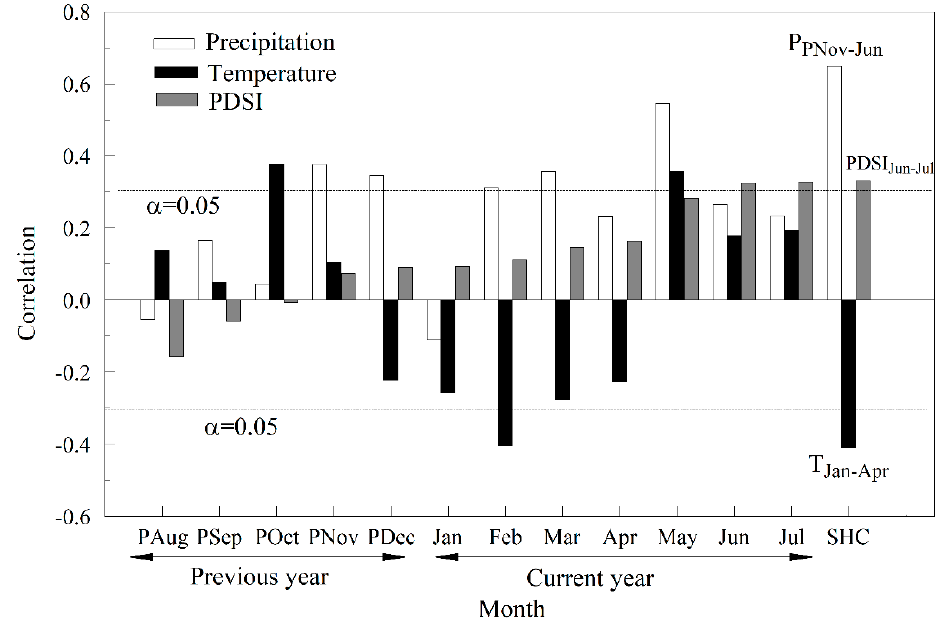
Figure 5. Correlation between the CNDVI JJ and several climatic parameters. Correlation between the CNDVI JJ of the CW–DHM and precipitation, temperature (both from CRU TS4.01, 47.5° N– 49.5° N, 119.0° E–120.5° E, 1982–2013 CE), and PDSI [23] (47.5° N–49.5° N, 119.0° E–120.5° E,